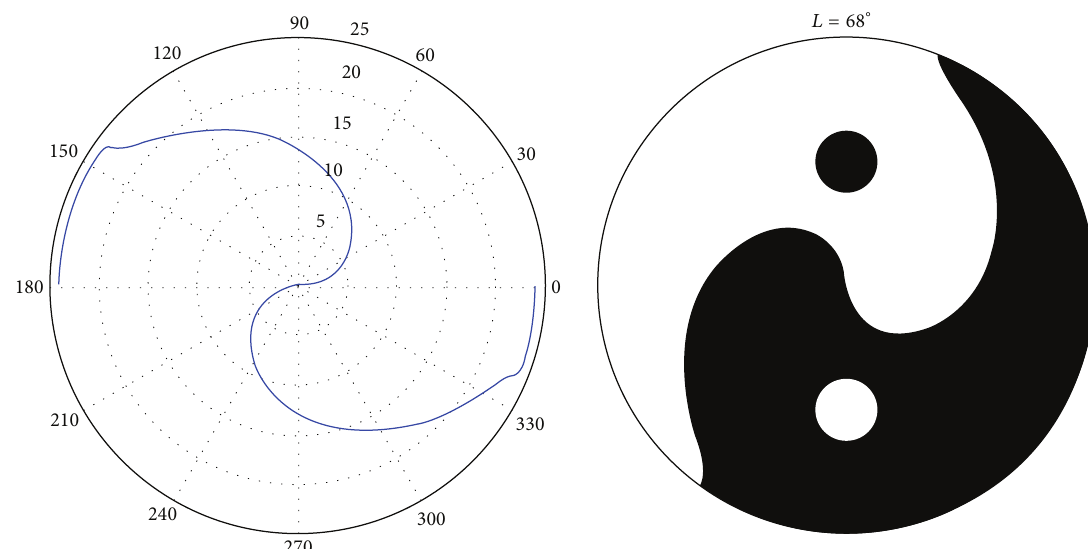
Figure 5: Yin-Yang symbol generated with the daylight model for 𝐿 = 68 ∘